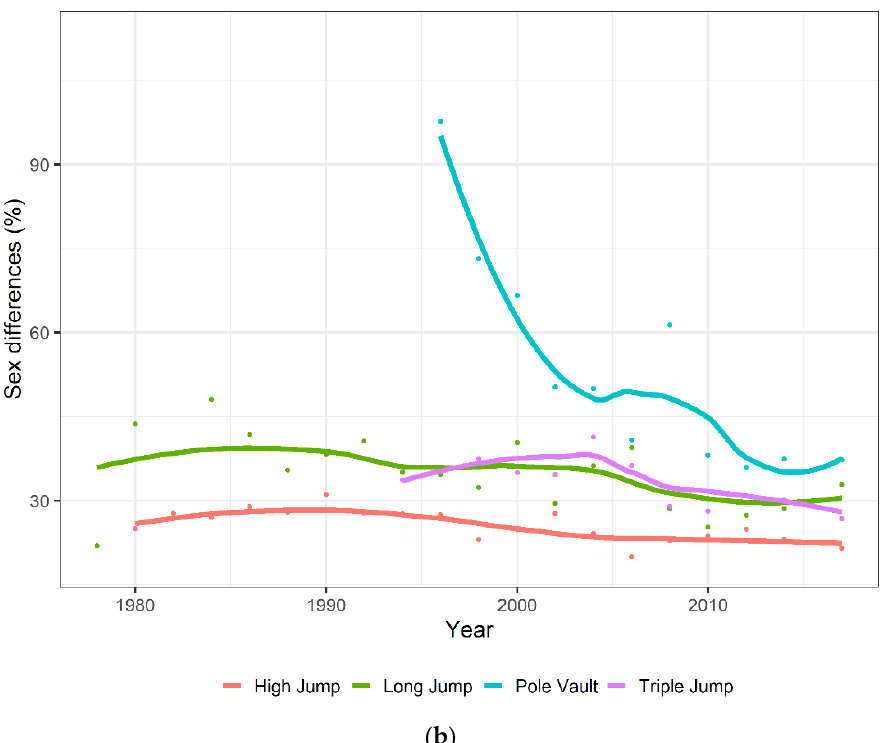
Figure 4. The sex differences (%) in performance of jumping events by age ( a ) and year ( b ). Age was defined as a continuous variable, considering the middle of the interval of each age group. Points are the observed means of the differences of the scores between males and females. Lines were the smoothed values of the observed means.